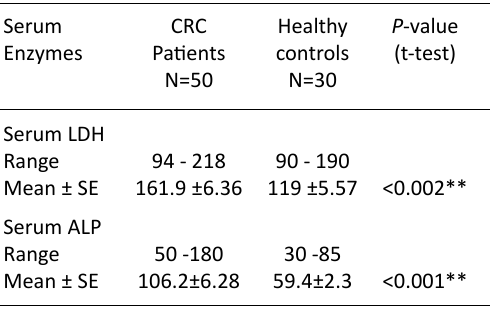
table 1. The difference in mean levels of serum enzymes (U/L) concentration between patients and controls